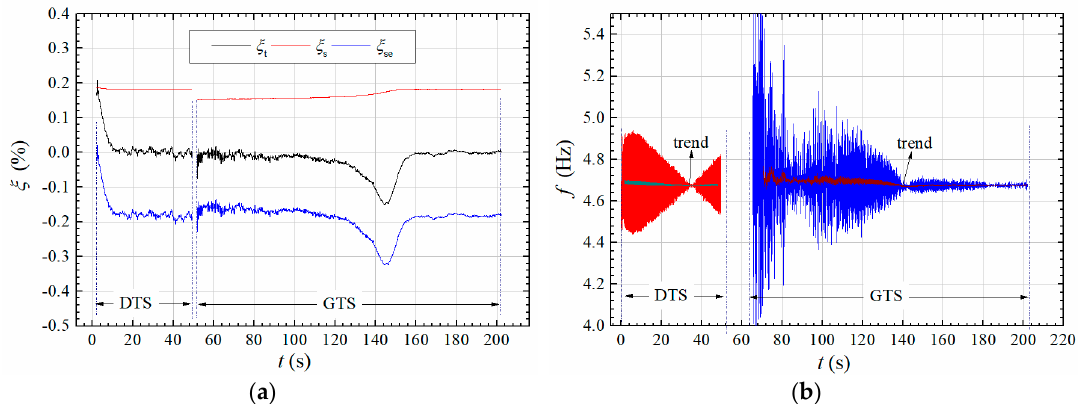
Figure 13. Evolution of amplitude-dependent ( a ) damping ratio; ( b ) vibration frequency during a post-critical LCO in Figure 12a (Case A1, U * = 3.456).